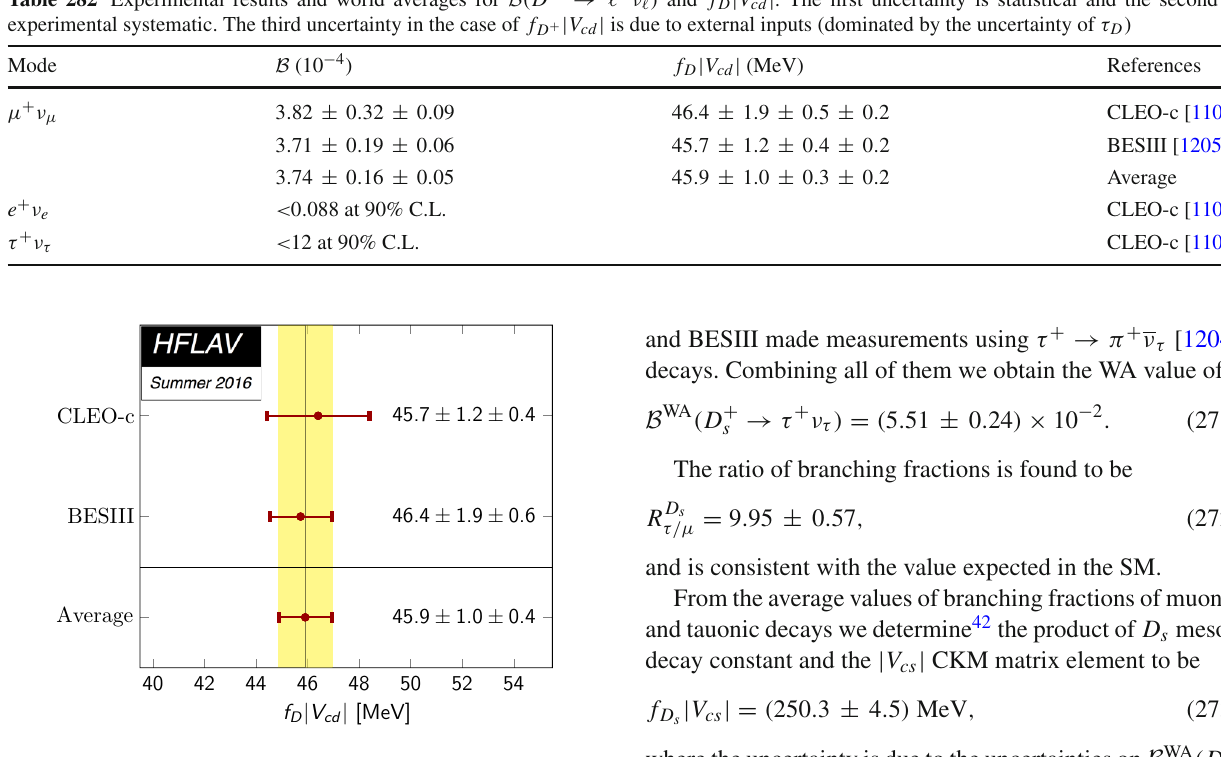
Fig. 205 WA value for f D | V cd | . For each point, the first error listed is the statistical and the second error is the systematic error